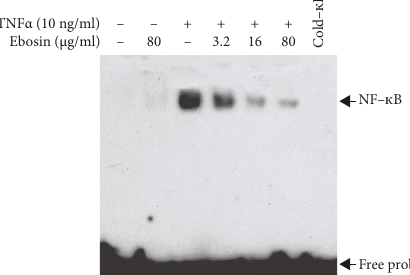
Figure 3: Ebosin inhibits NF- κ B DNA binding activity in FLS mediated by TNF- α . The DNA binding activity in the nuclear extracts of FLS mediated by TNF- α was assessed in an electrophoretic mobility shift assay (EMSA) by a speci fi c probe, an oligonucleotide labeled with biotin. A LightShift Chemiluminescent EMSA Kit was used following the instructions of the manufacturer. Speci fi c binding was controlled by competition with a 50-fold excess of cold κ B